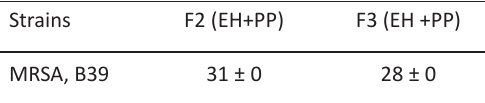
Table 4. Effect of F2 ( P. plebeium , PP and E. hirta , EH) & F3 ( P. plebeium , PP and E. hirta , EH) on MRSA,B39 Strains F2 (EH+PP) F3 (EH +PP) MRSA, B39 31 ± 0 28 ± 0